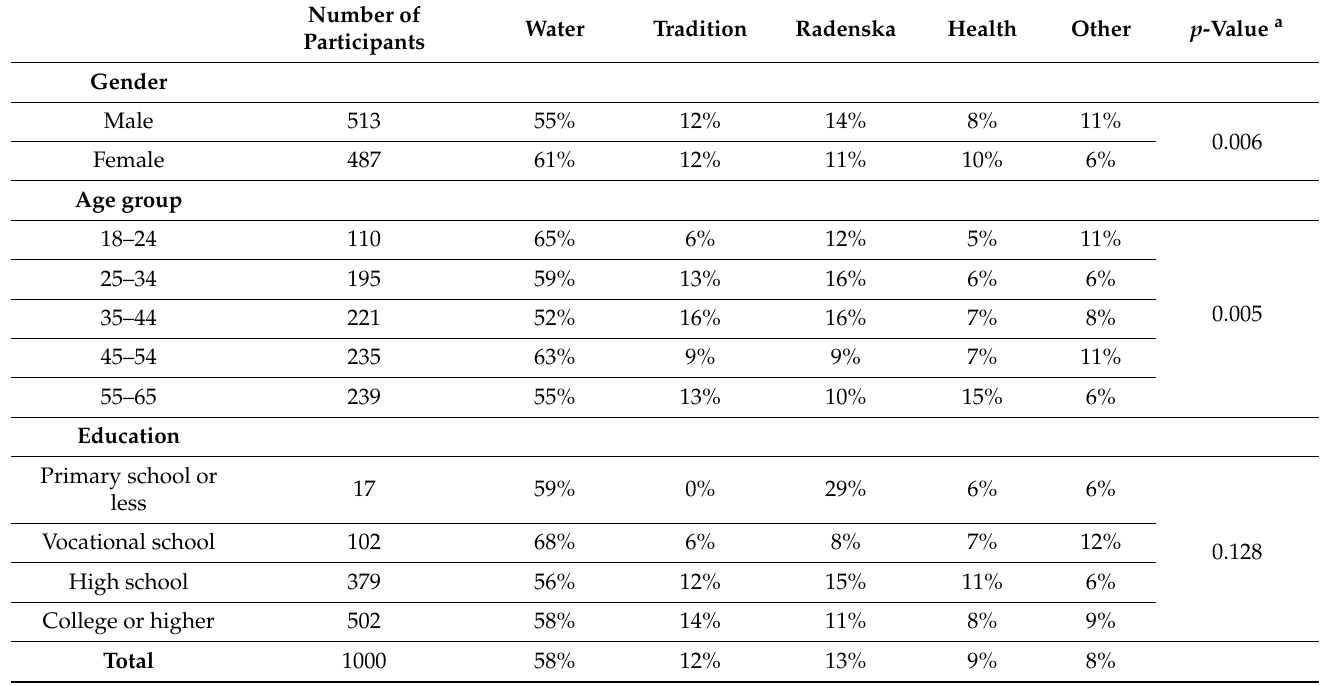
Table 5. Percentages of responses within association categories by gender, age and